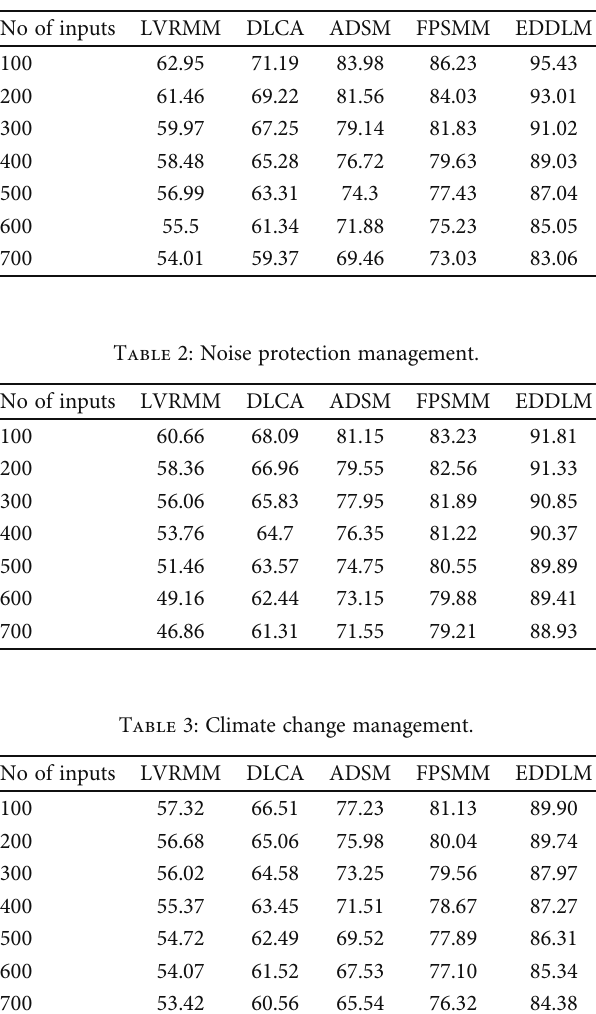
Table 1: Exterior thickness management.